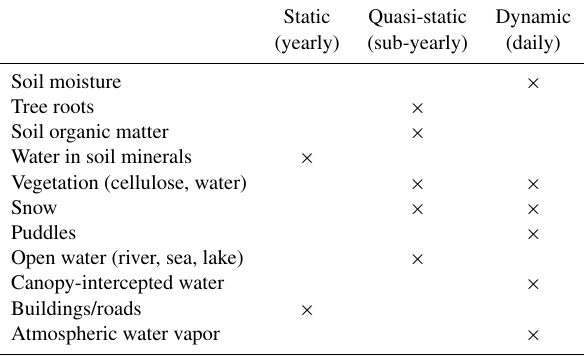
Table 1. Dynamics of different hydrogen